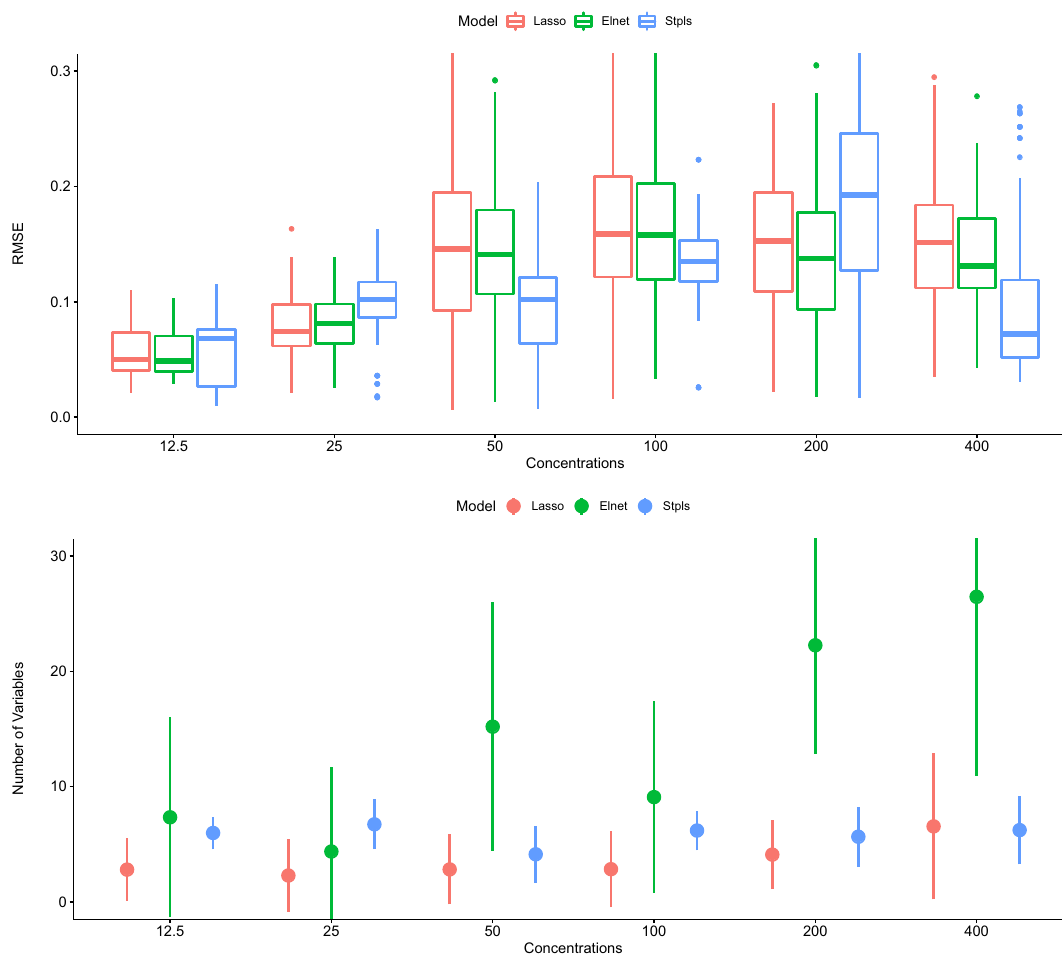
Figure 4. In the upper and lower panels, the distribution of RMSE computed from test data and the distribution of the number of selected variables through Lasso, Elnet and StPLS over all concentration levels is presented. Factors